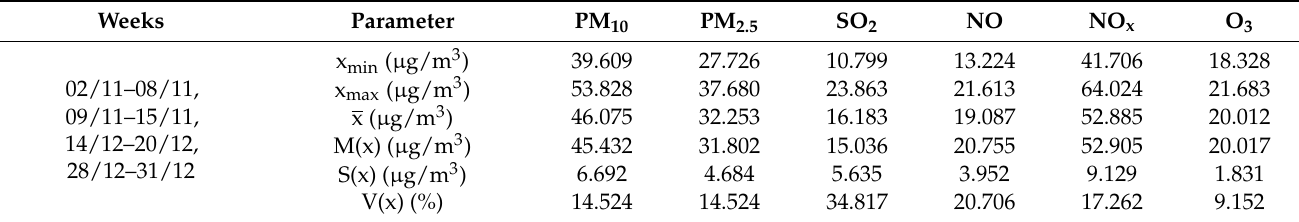
Table 4. Average measures and measures of relative variability for group no.